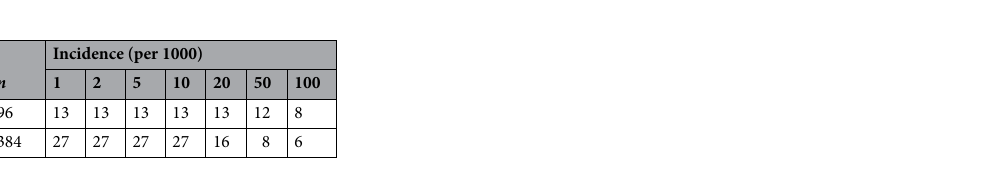
Table 3. Optimal pool sizes for OptReplica with respect to the incidence of the